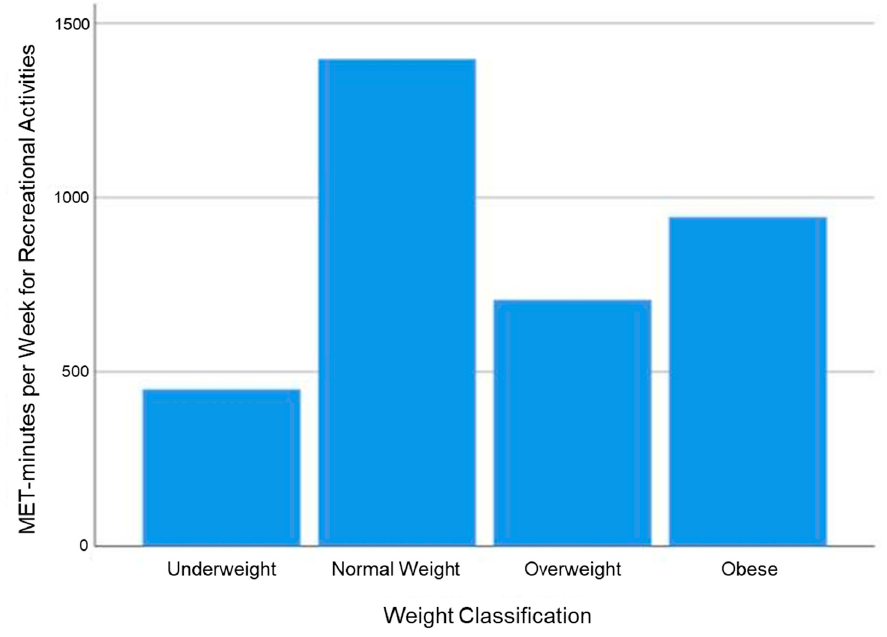
Figure 2. MET-minutes per week for recreational activities relative to weight classification of Turner syndrome patients. Chi-squared tests or Fisher’s exact test for counts smaller than five were applied to test for significance.